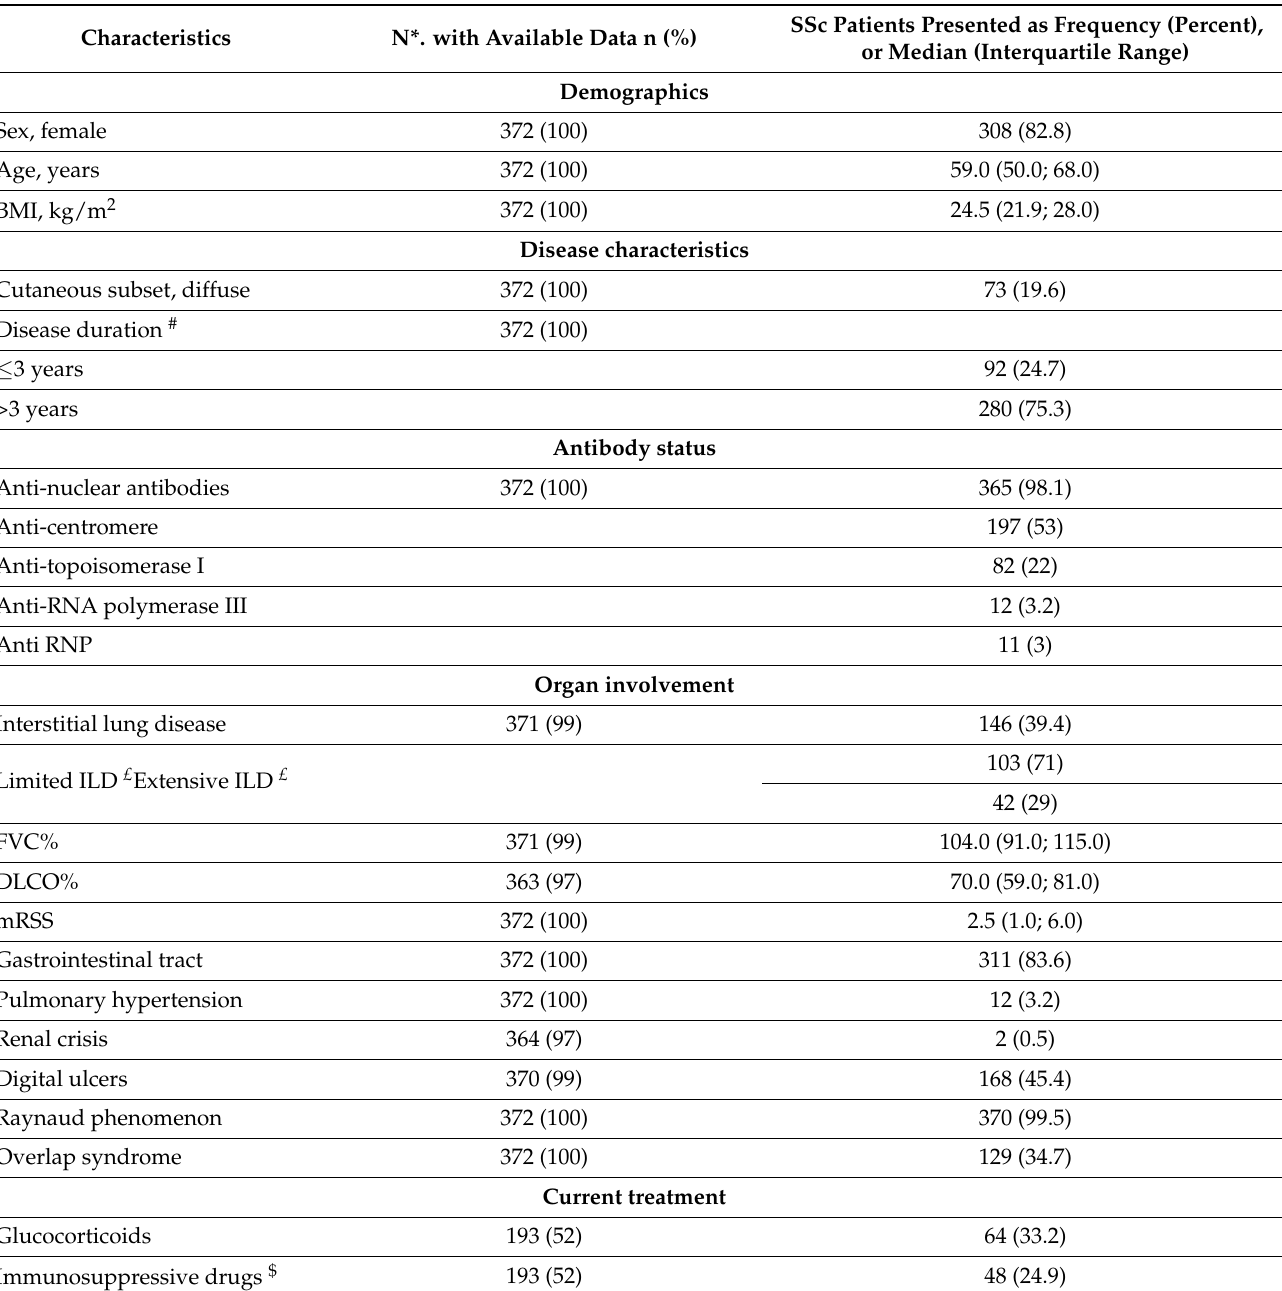
Table 1. Patients’ baseline